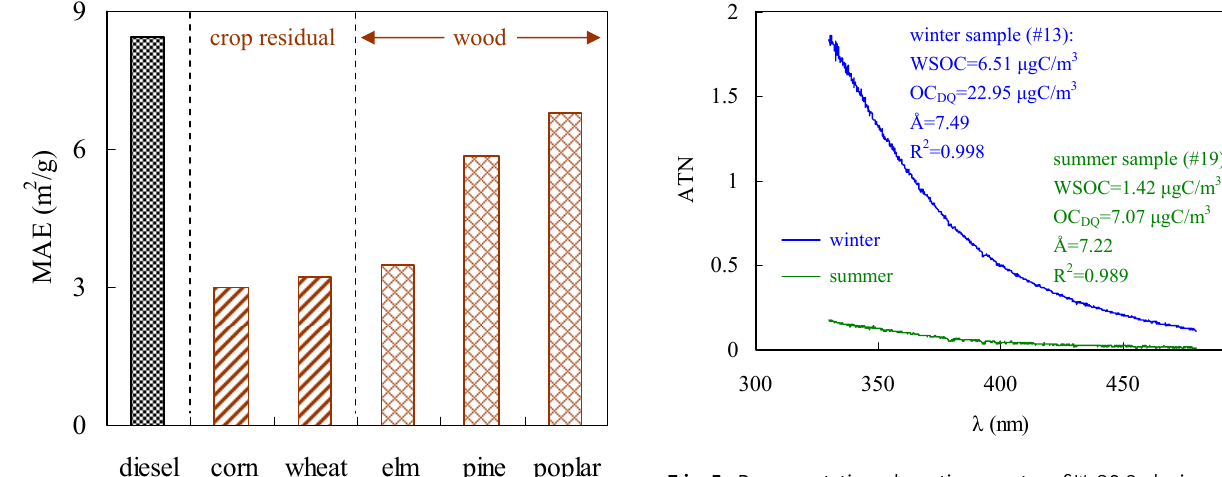
Fig. 5. Representative adsorption spectra of WSOC during winter Figure 5. Representative adsorption spectra of WSOC during winter and summer respectively. and summer